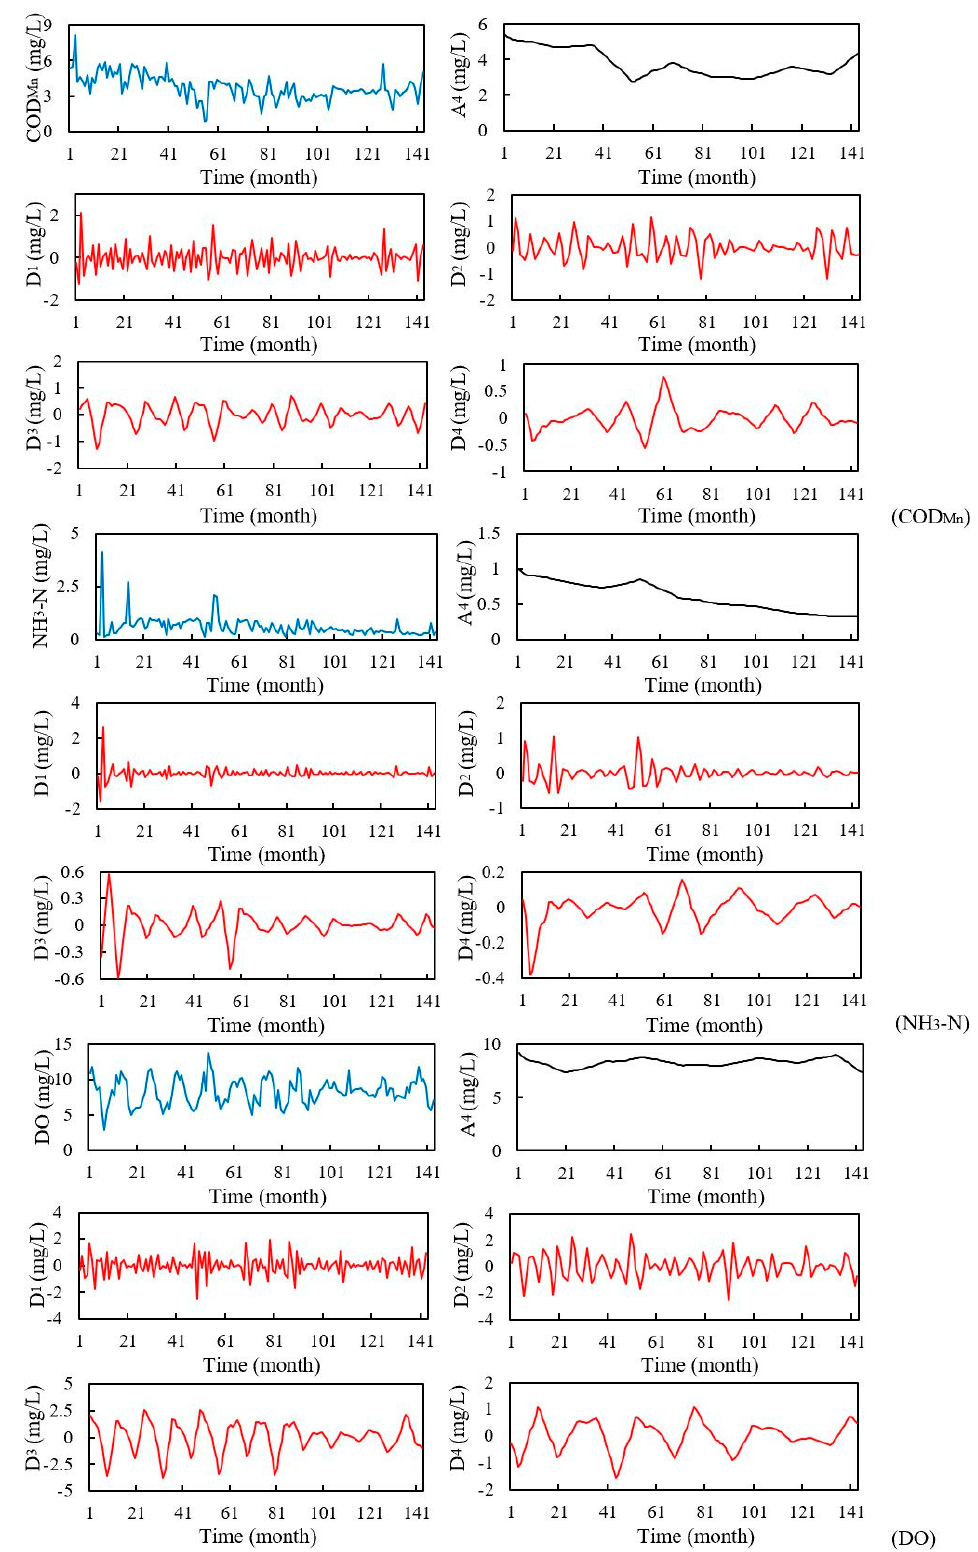
Figure 7. Approximation and detailed sub-series of monthly data using a db3 based on layer 4.